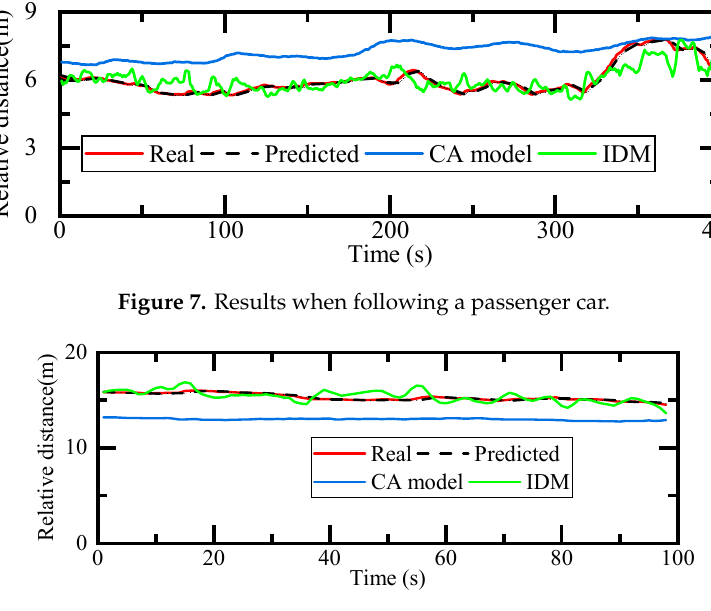
Figure 8. Results when following a bus.